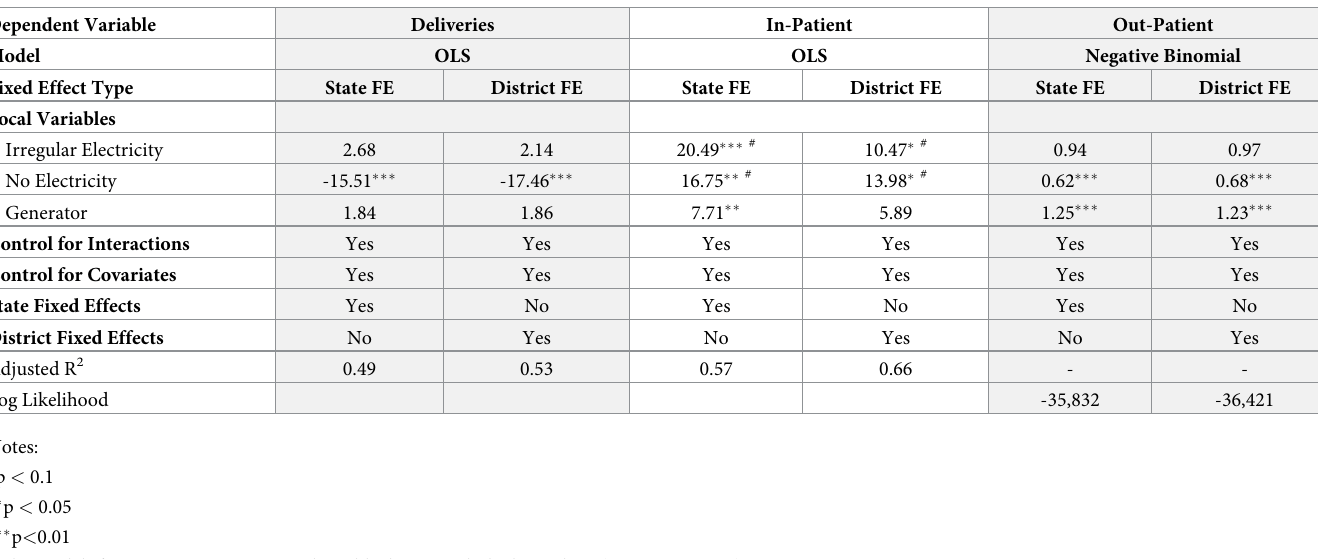
Table 6. OLS estimates and Incidence Rate Ratio (IRR) (exponentiated log-odds) for the focal variables in the regression models with state and district fixed